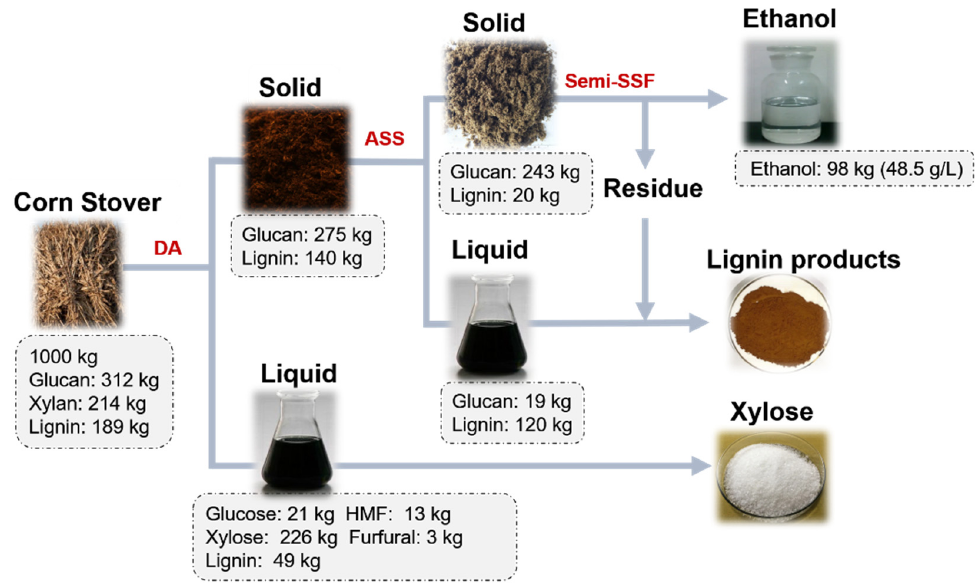
Figure 4. The sketch of the biorefinery of corn stover by joint pretreatment of DA and ASS and preliminary mass balance of the overall process.